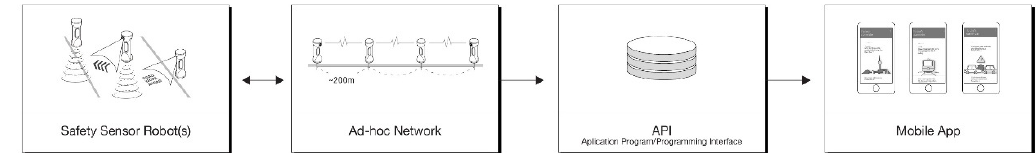
Figure 6. Process diagram: Sensor robot communicate via network infrastructure - API - mobile app.